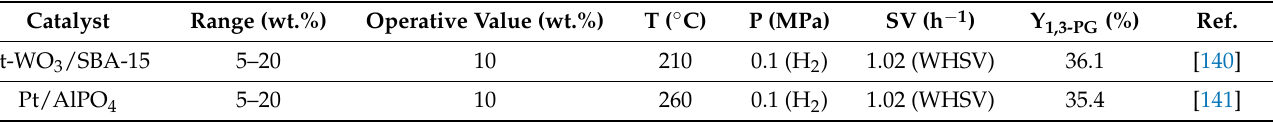
Table 8. The effect of glycerol concentration in the vapor phase using continuous flow reactors. Catalyst Range